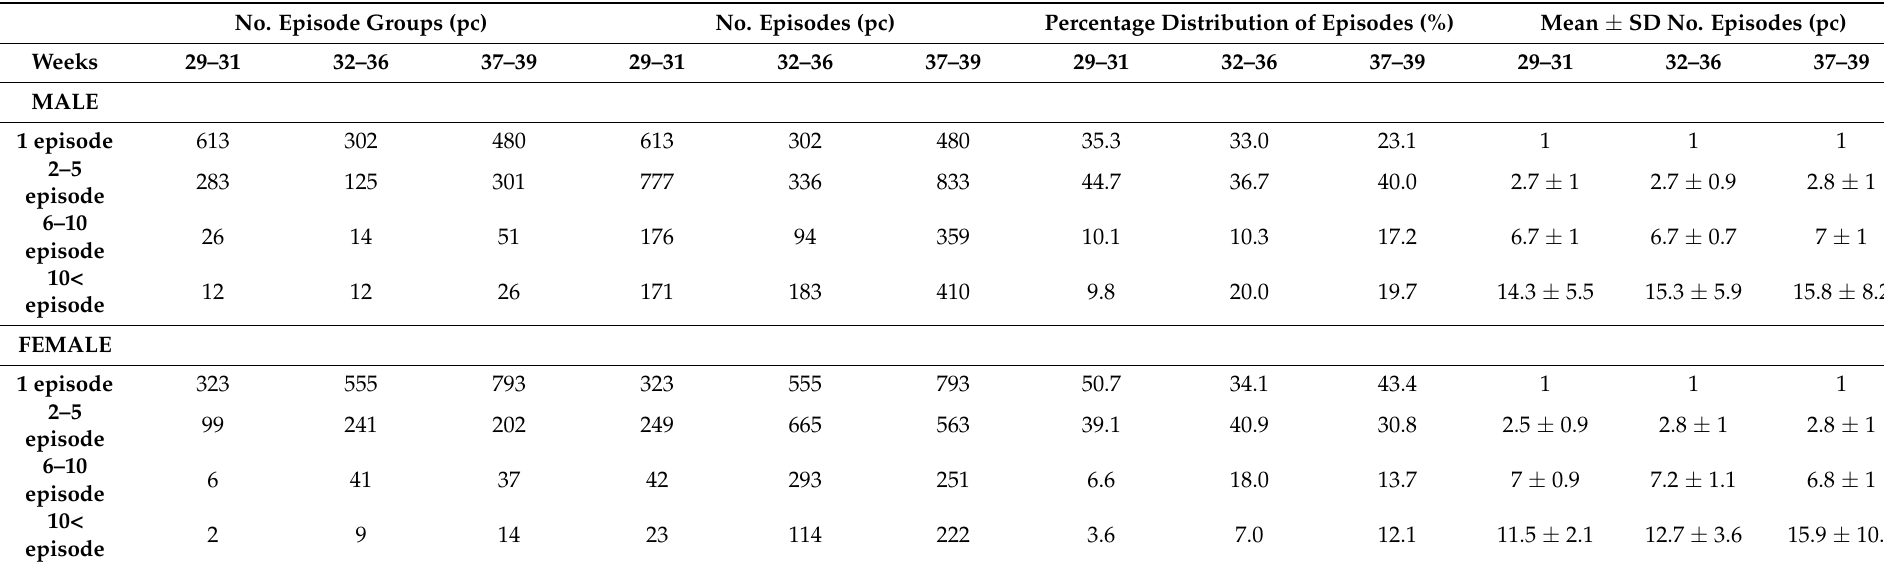
Table 3. The FBM episode groups’ formation during the different gestational ages in the last trimester at males and females